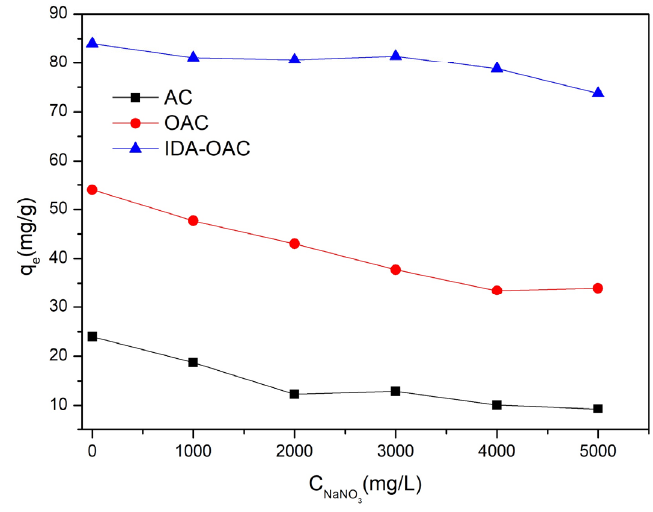
Figure 4. Effect of ion strength on the copper ion removal AC, OAC, and IDA-OAC.